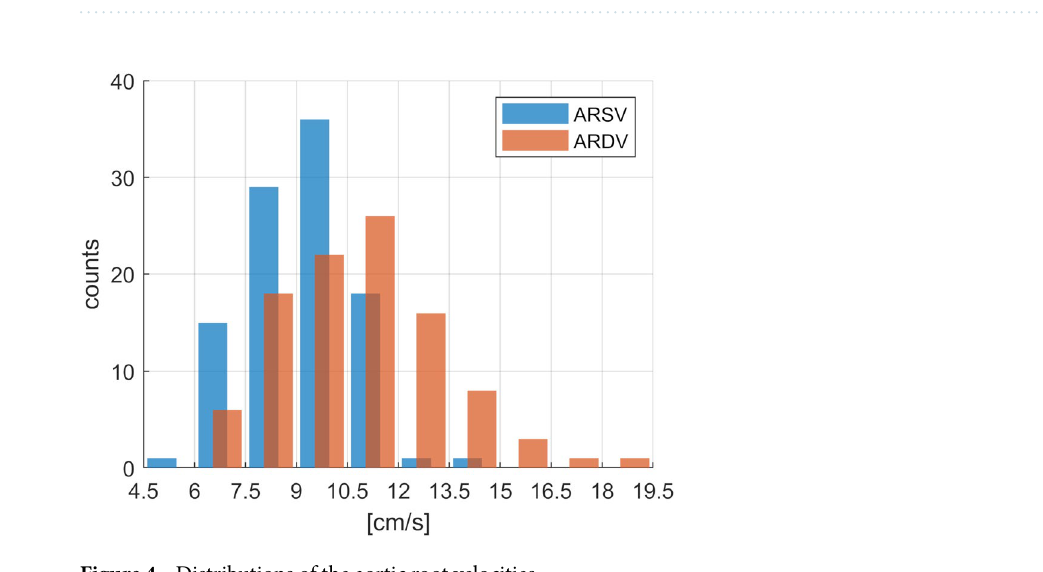
Figure 3. Distributions of the aortic root distances.